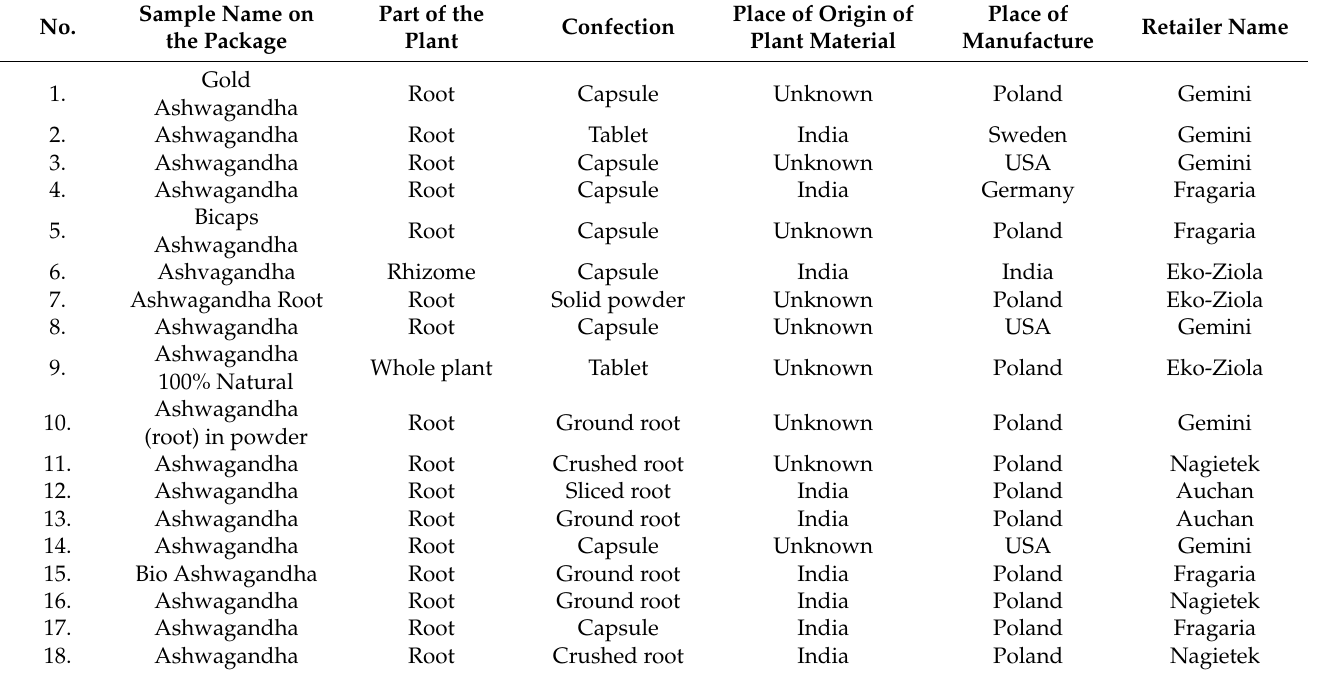
Table 1. List of analyzed commercial samples of W. somnifera